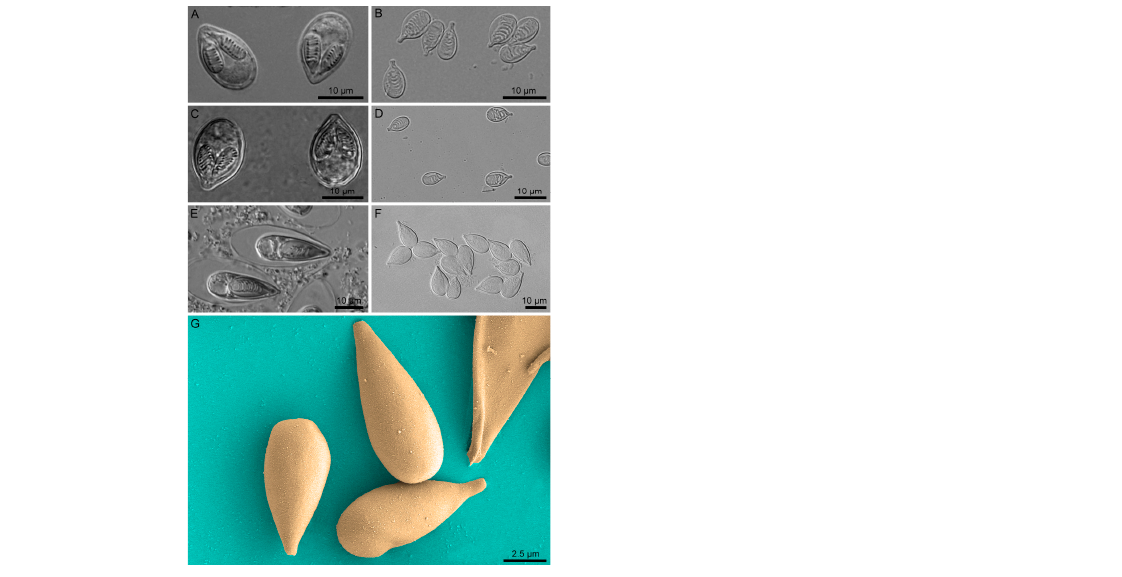
Figure 1. Light microscopy and scanning electron microscopy of myxozoan nematocysts. ( A , C , E ) Fresh and intact spores of Myxobolus honghuensis , Myxobolus wulii, and Thelohanellus kitauei . ( B , D , F ) Isolated nematocysts of M. honghuensis , M. wulii, and T. kitauei . ( G ) Scanning electron microscopy of the isolated T. kitauei nematocyst.